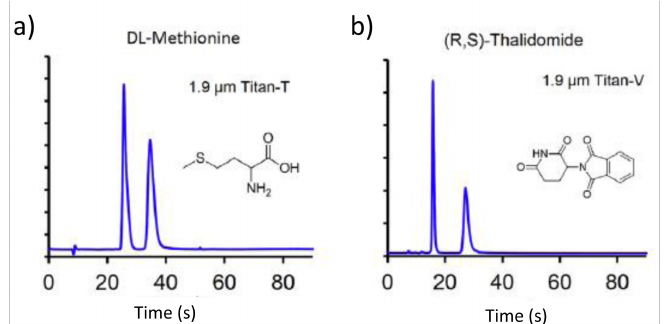
Figure 1. Examples of fast separations on 50 × 4.6 mm (L × I.D.) columns packed with nPSD 1.9 µ m FPP CSP. ( a ) chiral selector: teicoplanin, compound: DL-methionine, mobile phase: water/methanol 30%:70% ( v / v ), F v = 2 mL/min; ( b ) chiral selector: vancomycin, compound: ( R , S )-thalidomide,